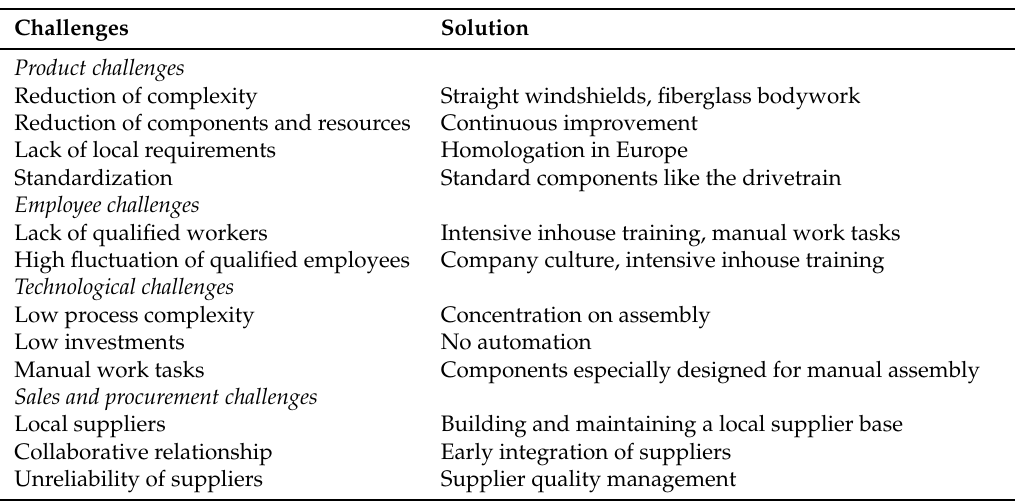
Table 3. Challenges and solutions: Wallys